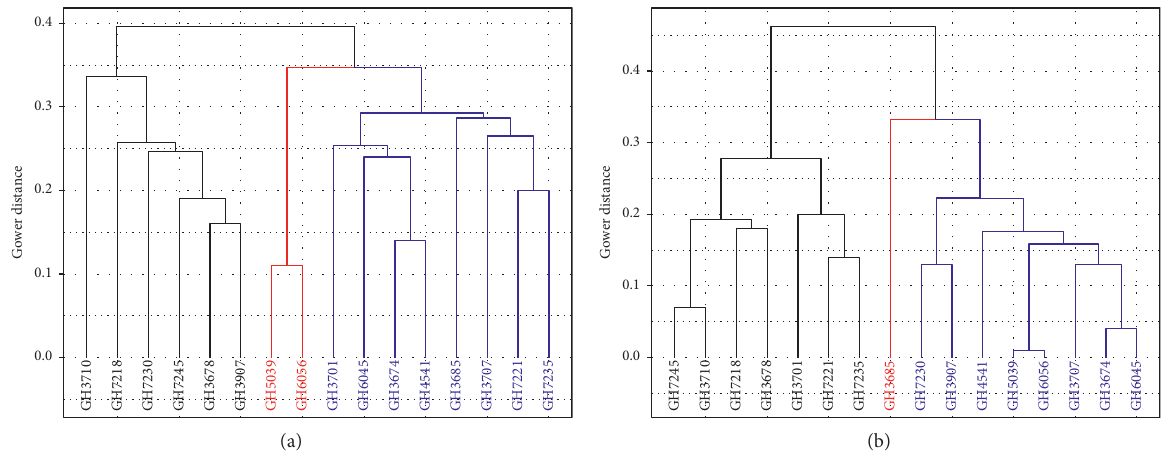
Figure 4: Dendrogram showing relatedness among the cowpea accessions. (a) Agromorphological; (b)